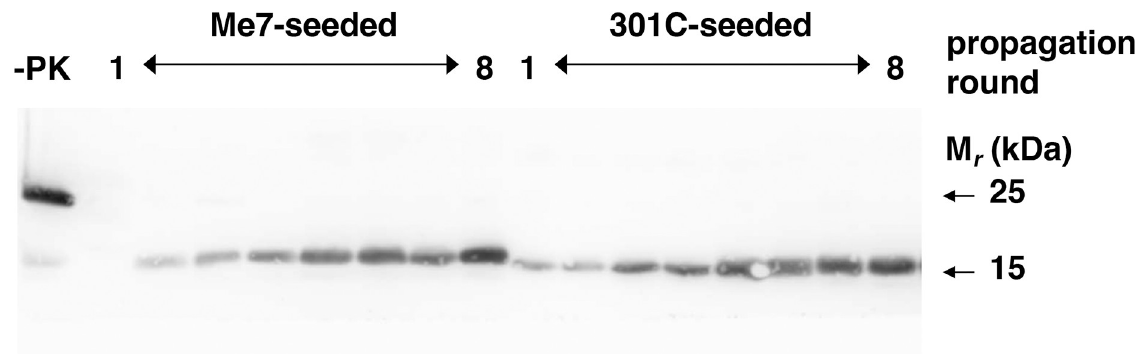
Fig 1. Shaking-generated wild-type Mo recPrP Sc molecules. Western blot showing rounds 1–8 of serial propagation shaking reactions containing wild-type Mo recPrP substrate plus purified brain phospholipid cofactor initially seeded with Me7 or 301C brain homogenate, as indicated. (-PK) = sample not subjected to proteinase K digestion; all other samples were proteolyzed.